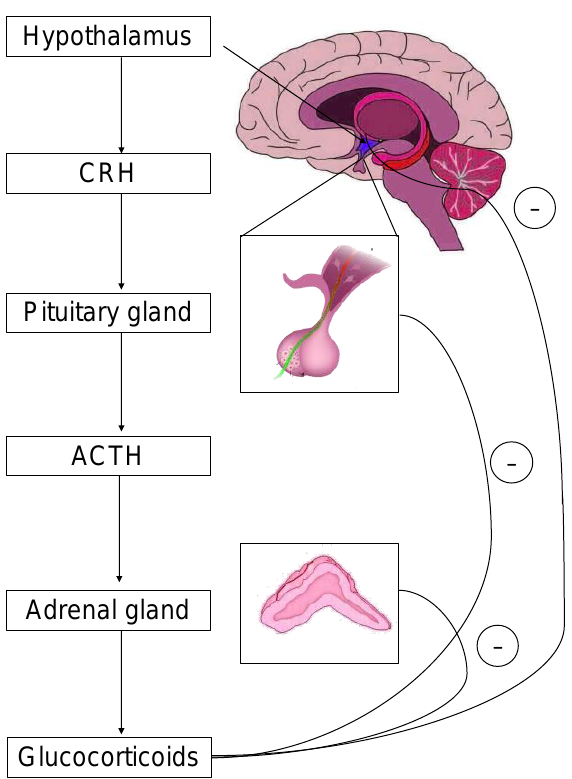
Figure 1. The hypothalamic–pituitary–adrenal (HPA) axis is the primary effector of a stress response. Critical hormones and organs are shown, whereas cycles with the negative symbol indicate negative feedback mechanisms.